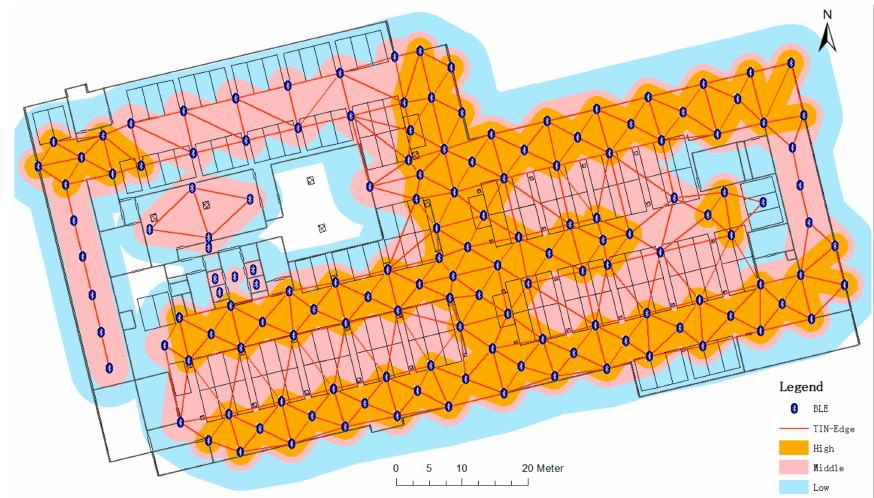
Figure 8. Reference beacon coverage rating map of the